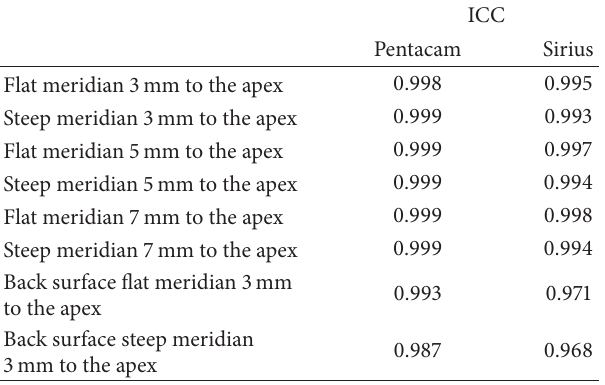
Table 2: Interobserver variability of keratometry in healthy corneas (ICC = intraclass correlation coefficient).